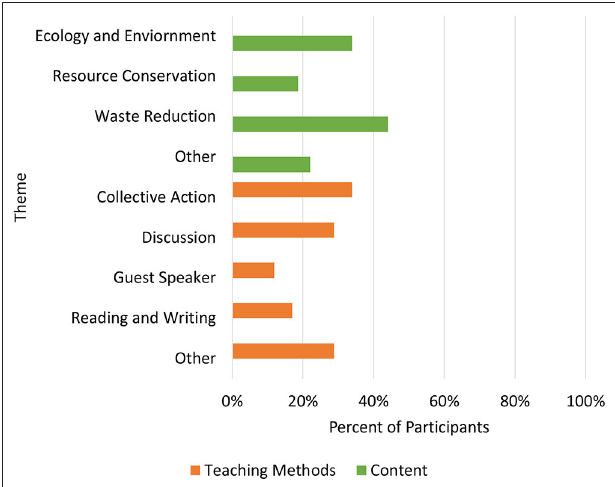
FIGURE 9 | The percent of participants ( n = 59) that mentioned each theme in their descriptions of an activity or lesson that they use to meet Standard 3 in their